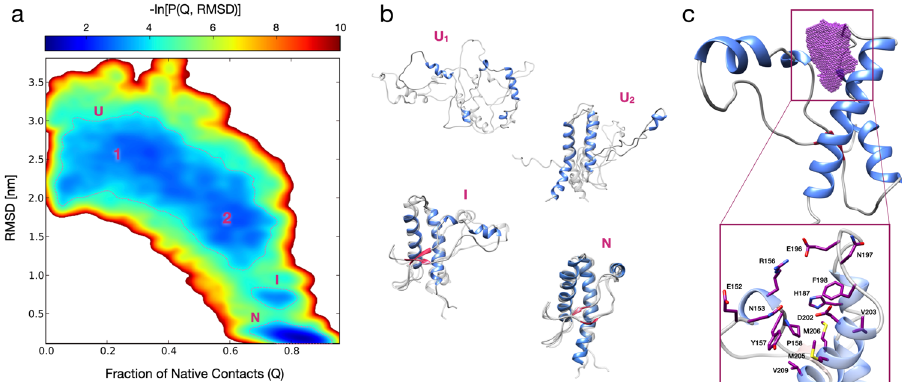
Fig. 1 All-atom reconstruction of the PrP folding pathway. a Lower-bound approximation of the free energy landscape of the PrP folding obtained from 180 rMD trajectories, plotted as a negative logarithm of the probability distribution expressed as a function of the collective variables Q (fraction of native contacts) and RMSD. The dashed lines delimit the metastable regions of interest (G ≤ 3.7 k B T). b Representative PrP structures of unfolded (U1 and U2), folding intermediate (I) and native conformations (N). Each conformation represents the cluster center of one of the corresponding populated regions (structures depicted in transparency are sampled from the same region, showing conformations variability): the fi rst two (corresponding to the unfolded states U1 and U2) are characterized by RMSD >1.8 nm and a Q < 0.5 (U1), and 1.2 < RMSD < 1.8 nm and a 0.5 < Q < 0.75 (U2); a third one (corresponding to the intermediate folding state I) with 0.55 < RMSD < 0.90 nm and a 0.65 < Q < 0.85; a fourth one (corresponding to the native state N) with RMSD < 0.40 nm and Q > 0.80. c Ribbon diagram of the PrP intermediate highlighting the ligand-binding pocket (purple dots) as identi fi ed by SiteMap and DogSiteScorer tools. The purple volume maps the unique druggable pocket identi fi ed in the PrP-folding intermediate I. The box shows speci fi c residues de fi ning the